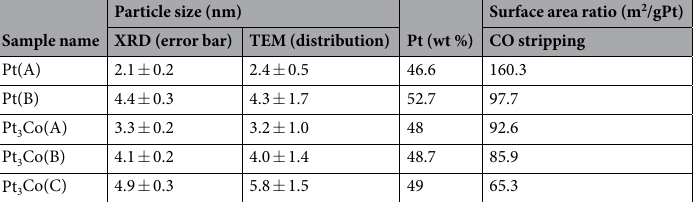
Table 1. Sample specifications (Pt and Pt 3 Co nanoparticles loaded on a carbon